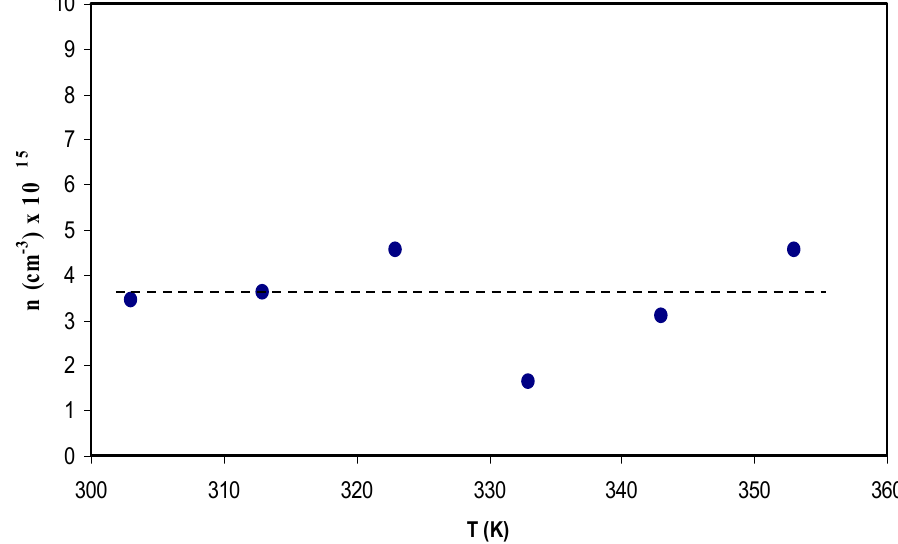
Figure 12. Charge carrier density ( n ) of ions versus temperature for the CS: POZ: MgTf system.